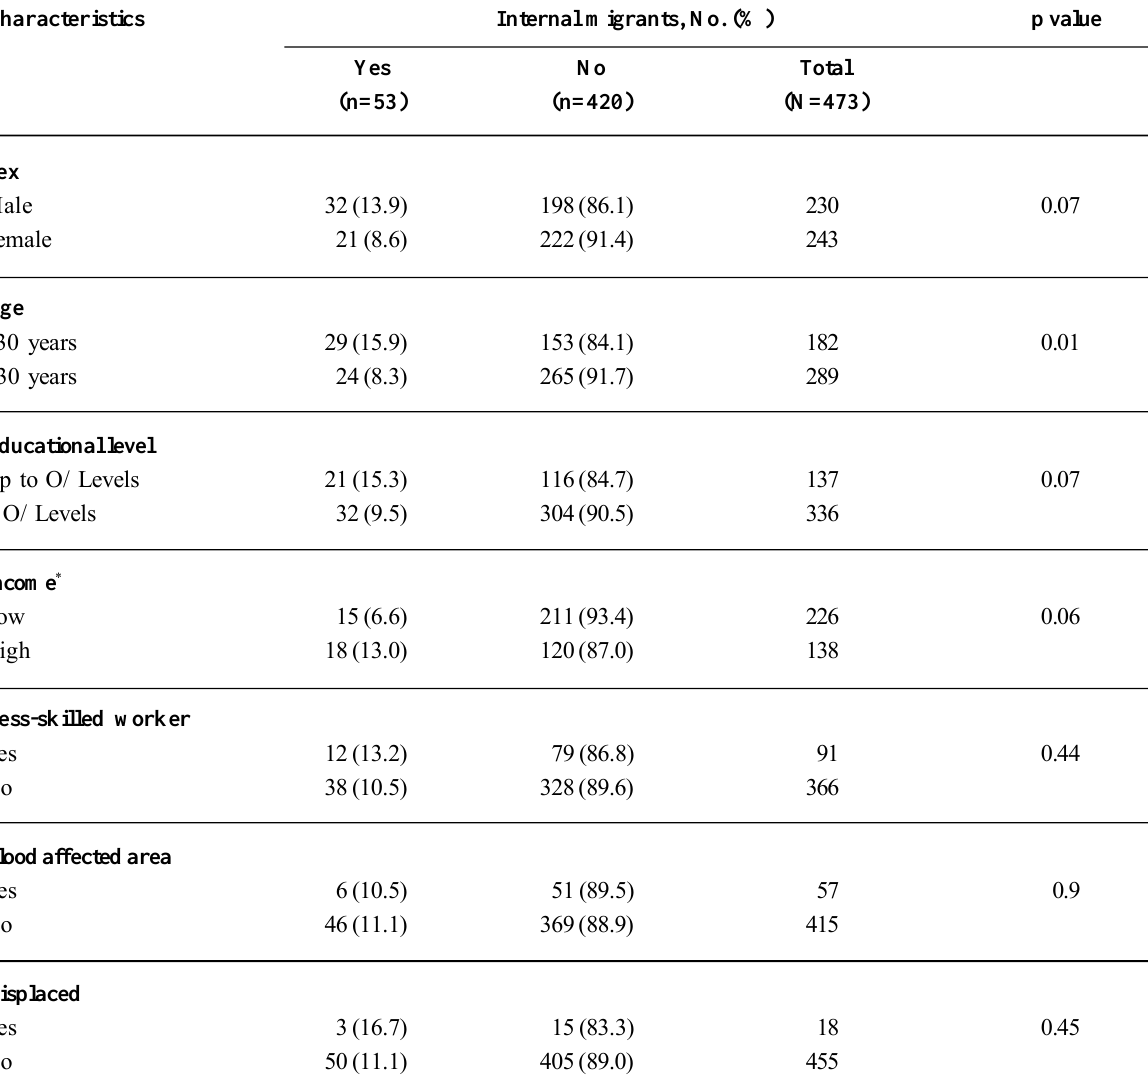
Table 1. Association between socio-demographic characteristics